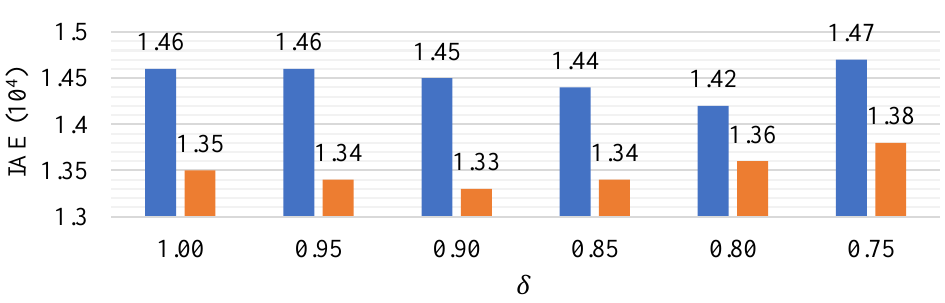
Figure 11. The effect of δ on the MPC performance that was adaptive only in A ( z − 1 ).